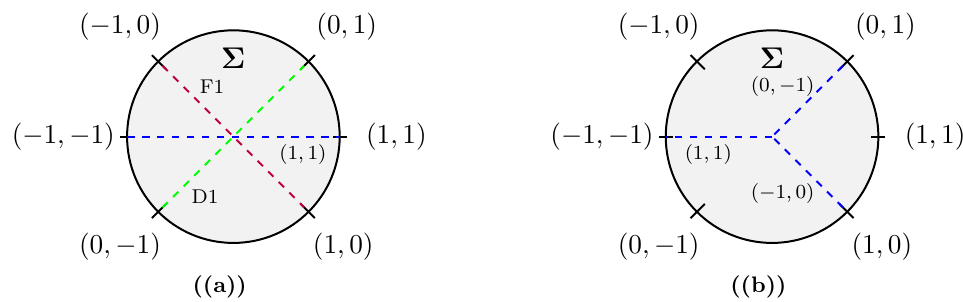
Figure 13. Disc representation of the 6-pole solutions with residues given in (4.45). On the left hand side strings connecting like poles. On the right hand side the